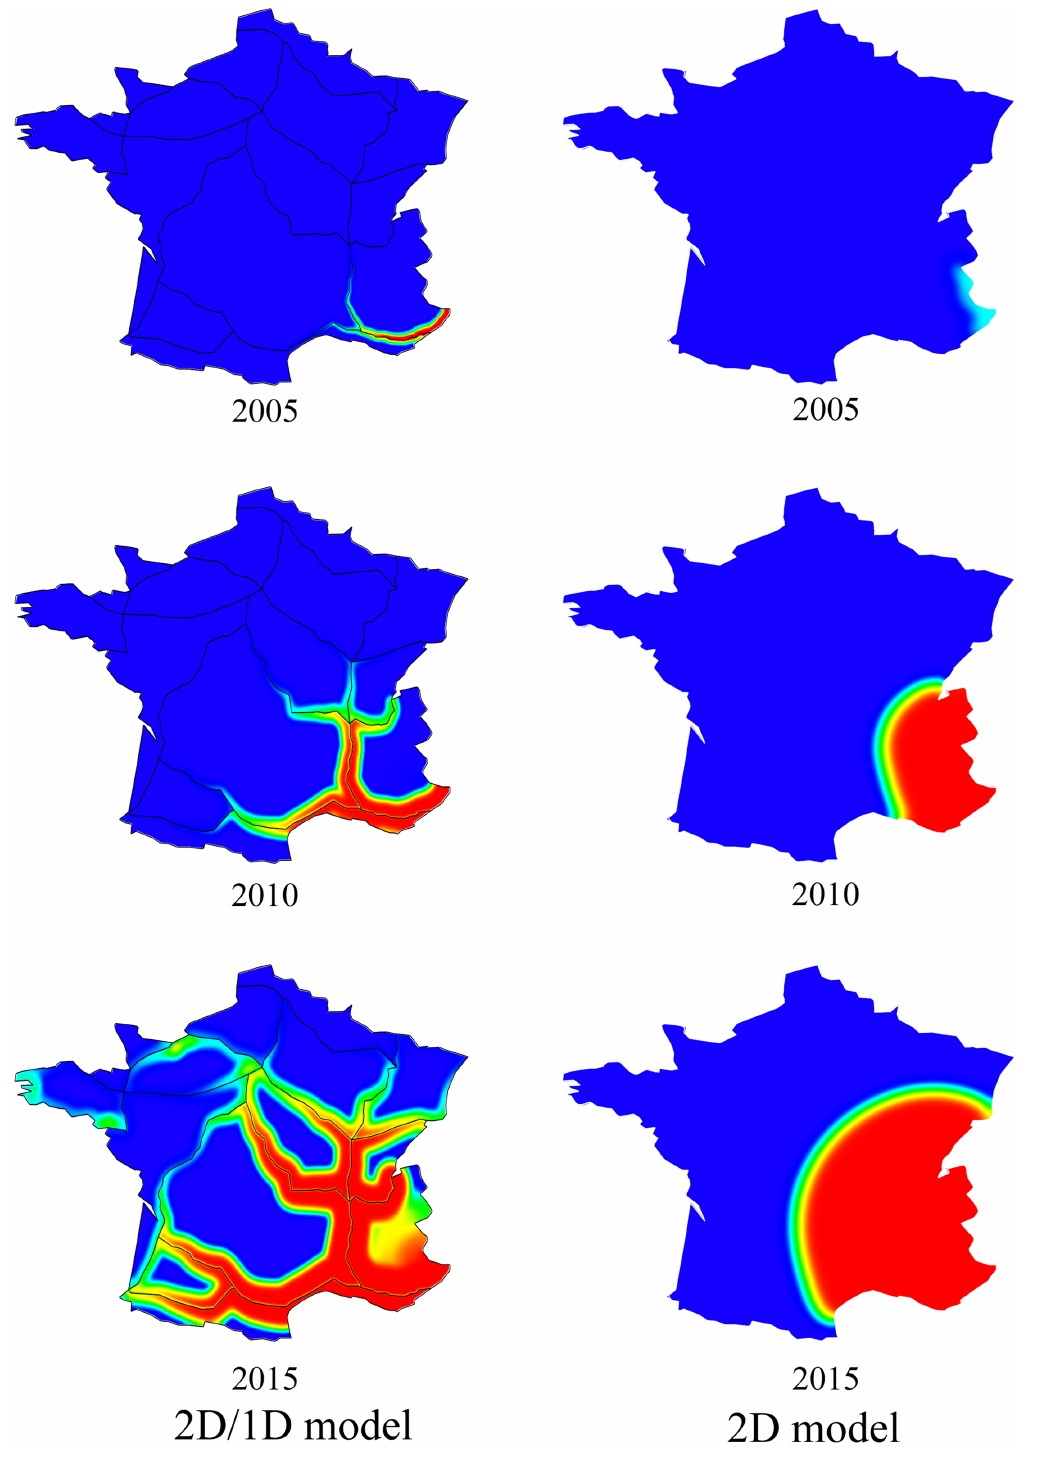
Fig 5. Simulation results. Left: dynamics of the mosquito population density corresponding to the solution of the 2D/1D model with the parameter value Θ * given by maximum-likelihood estimation. Right: dynamics of the mosquito population density given by the 2D model with the maximum-likelihood estimator ~ Y . Values range from 0 (blue) to 1 (carrying capacity,